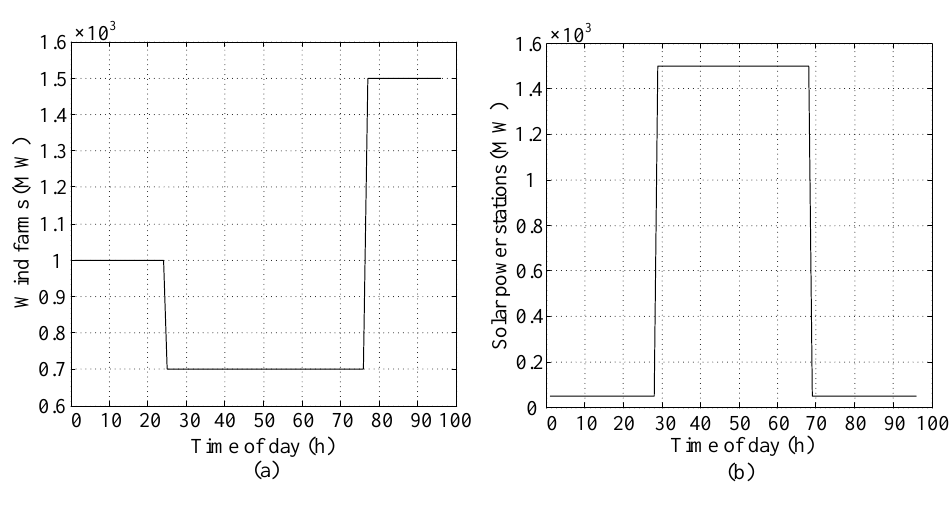
Figure 3. Generation of electricity: ( a ) Wind farms; ( b ) Solar power